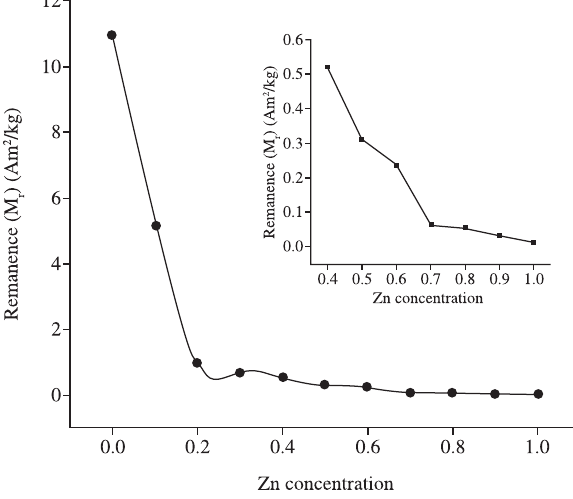
Zn Fe O , (d) Ni 0.80 0.20 2 4